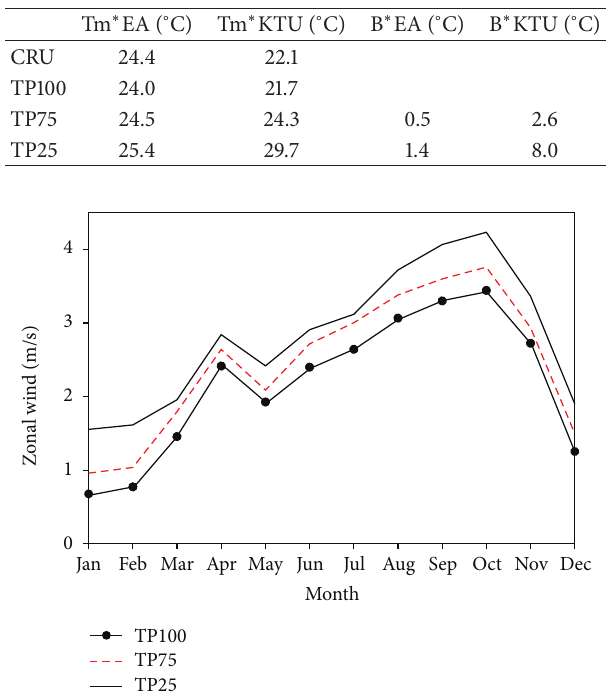
Figure 7: The mean annual cycle of the zonal wind magnitude (in ms −1 ) for the period 2000–2008, averaged over longitudes 28 ∘ E– 42 ∘ E and latitudes 12 ∘ S–5 ∘ N. TP100 is due to the simulation with actual topography, TP75 is due to the simulation with topography reduced to 75%, and TP25 represents simulation when the topogra- phy is reduced to